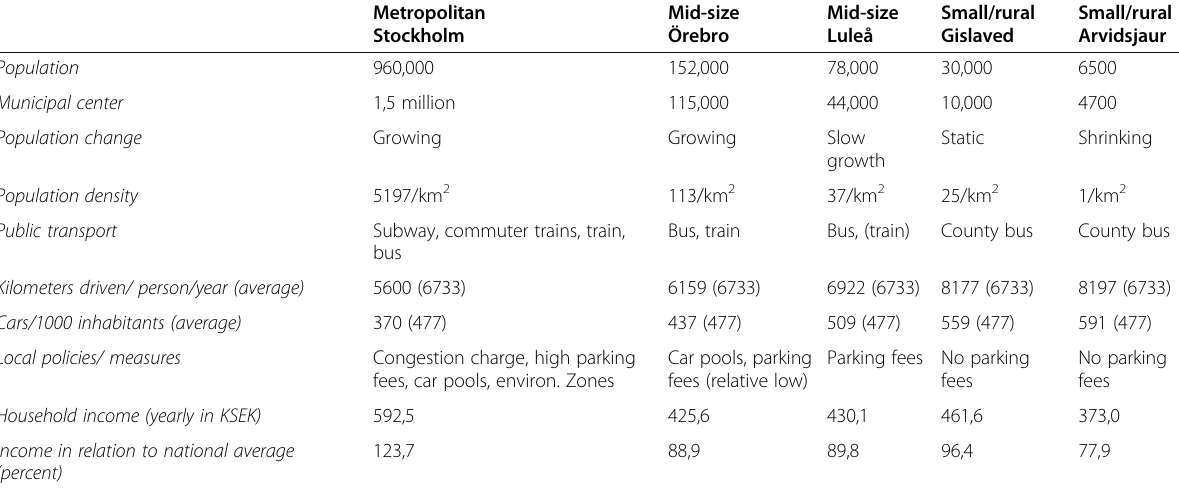
Table 1 Selected characteristics in the